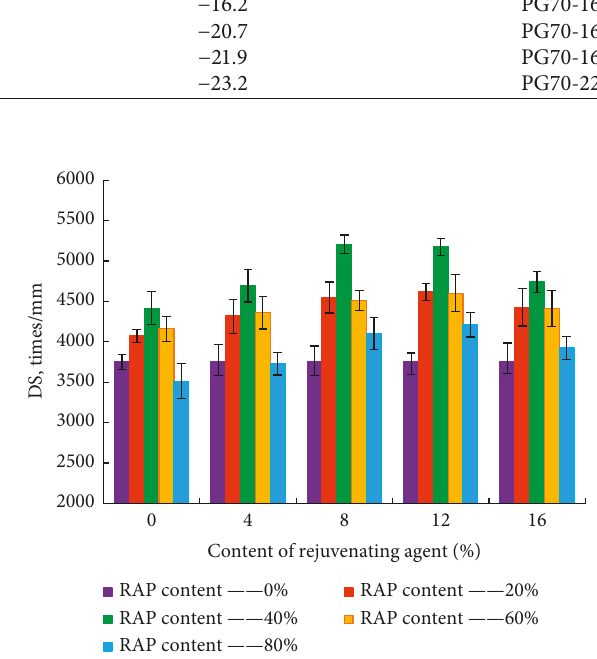
Figure 1: DS test results with different content of regenerant.